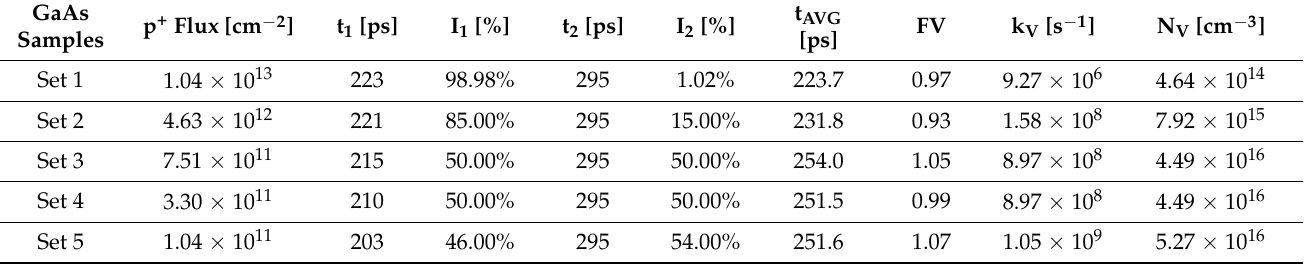
Table 3. Experimental results of the PAS.